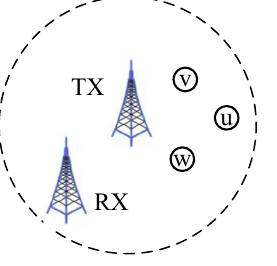
Figure 1. Sense-in-order can reduce delay and save